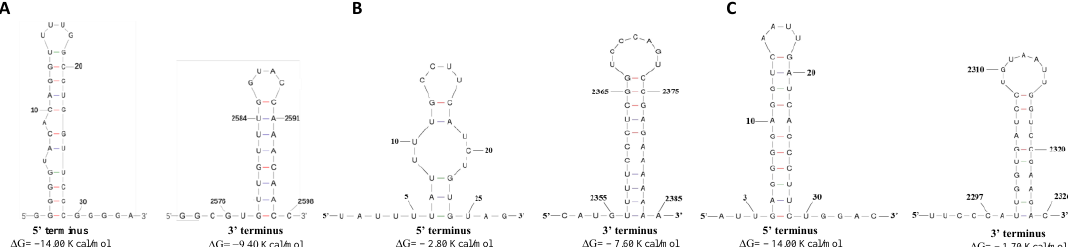
Figure 3. Predicted secondary structures of the MOBV5, MOBV6, and MOBV7 terminal sequences. ( A ) The predicted secondary structures of the 5 ′ - and 3 ′ - terminal sequences of MOBV5. ( B ) The predicted secondary structures of the 5 ′ - and 3 ′ - terminal sequences of MOBV6. ( C ) The predicted secondary structures of the 5 ′ - and 3 ′ - terminal sequences of MOBV7. The RNAfold server was used for predicting the secondary structures of the termini, and for calculating the free energies as well. The 5 ′ and 3 ′ -terminal sequences of each virus are folded to form potential stable stem-loop structures.